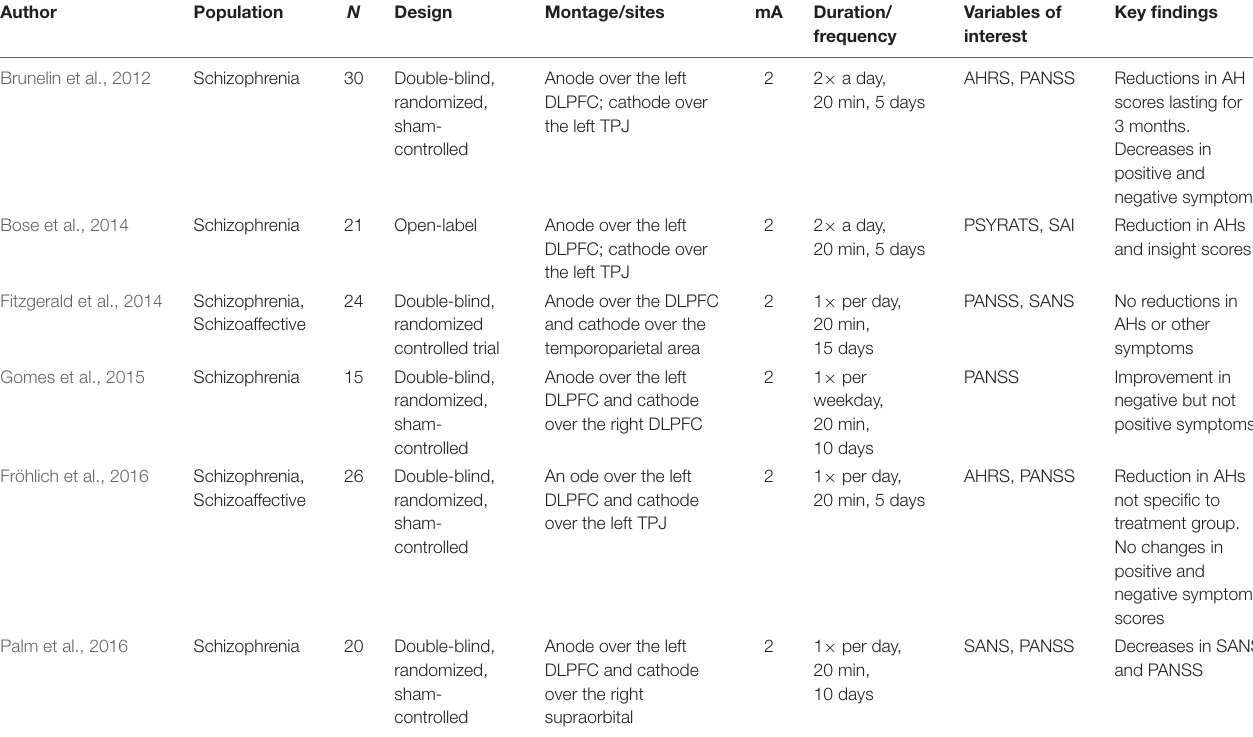
TABLE 1 | Summary of tDCS and clinical symptoms studies